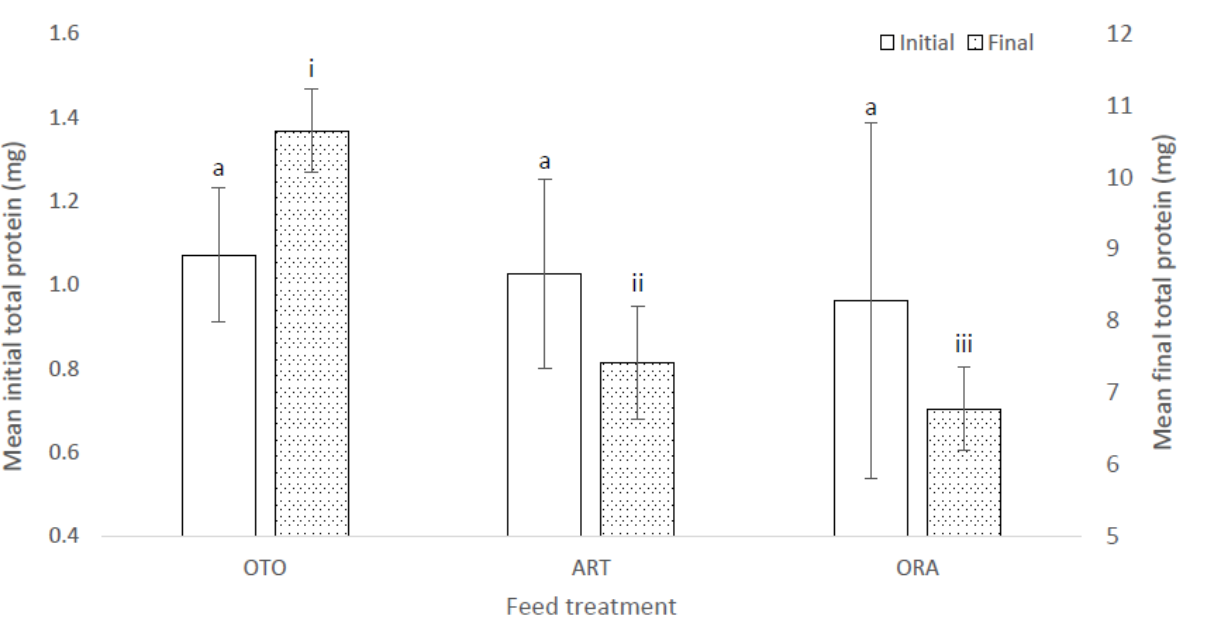
Figure 7. Mean proportional protein content measured as a percentage of dry weight (DW) for larval giant kōkopu at initial and final sampling for three feed treatments; i.e., OTO (Otohime), ART (Artemac) and ORA (O.range) (mean ± SE). Means with different superscripts are significantly different within each of the set of three treatment means for each sampling event ( p < 0.05).